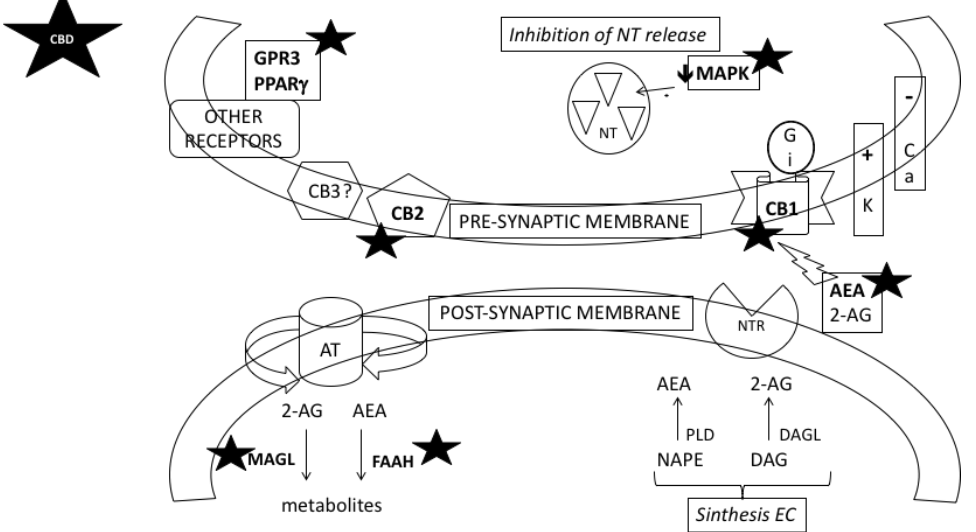
Figure 1. Components of cannabinoid synapsis modulated by CBD ( ★ ). The two main endocannabinoids (EC), anandamide (AEA) and 2-arachidonylglicerol (2-AG), are synthesized in the post-synaptic nerve terminal. AEA is produced by hydrolysis of N-arachidonyl phosphatidylethanolamine (NAPE) which is catalized by the enzyme phospholipase D (PLD). 2-AG is produced by the metabolism of diacylglicerol (DAG) by specific diacylglicerol lipases (DAGL). These EC act mainly through cannabinoid CB1 and CB2 receptors, although other receptors have been identified as targets of EC including a non-cloned CB3 receptor, GPR3, and the peroxisome proliferator activated-receptor gamma (PPARg). EC function as retrograde signalling molecules that inhibit the release of classical anterograde neurotransmitters (NT) by presynaptic terminals and binding with their receptor (NT receptor, NTR). After the activation of presynaptic CB1 receptors (by AEA or 2-AG), different signal transduction mechanisms are stimulated via G inhibitory proteins. EC reduce activity of protein kinases, as mitogen-activated protein kinase (MAPK), modulate ion channels (stimulation of potassium and inhibition of calcium channels) and inhibit NT release. The activity of endocannabinoids is limited by a transporter (AT) that reuptakes AEA and 2-AG into the post-synaptic cell. AEA is degraded by the enzyme fatty acid amidohydrolase (FAAH) and 2-AG is degraded by the enzime monoacylglicerol lipase (MAGL). CBD has been demonstrated to modulate anandamide signalling, CB1 and CB2 receptors, GPR3 and PPARg receptors and the activity of the enzymes FAAH and MAGL.